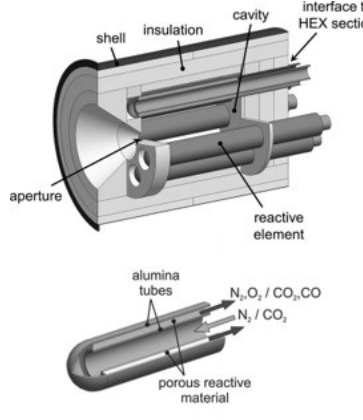
Figure 12. Indirectly heated solar reactor/receiver for water-splitting redox cycle on ceria (top) and detail of the reactive element. Reprinted from [119] with permission from